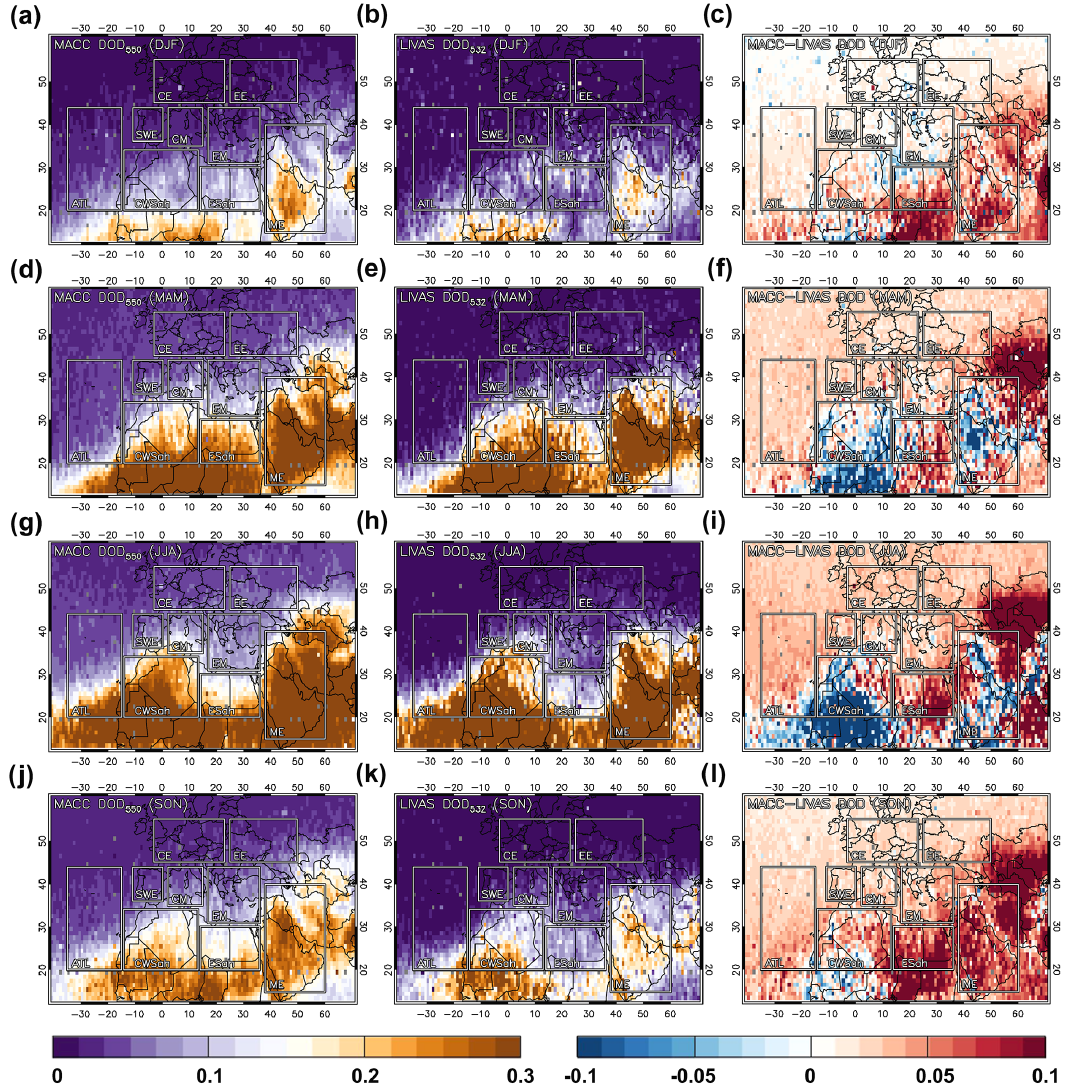
Figure 3. Seasonal patterns of the MACC DOD 550 (left column), the LIVAS DOD 532 (middle column) and the MACC–LIVAS mean bias (right column) over the Europe–northern Africa–Middle East domain for winter (DJF) (a, b, c) , spring (MAM) (d, e, f) , summer (JJA) (g, h, i) and autumn (SON) (j, k, l)